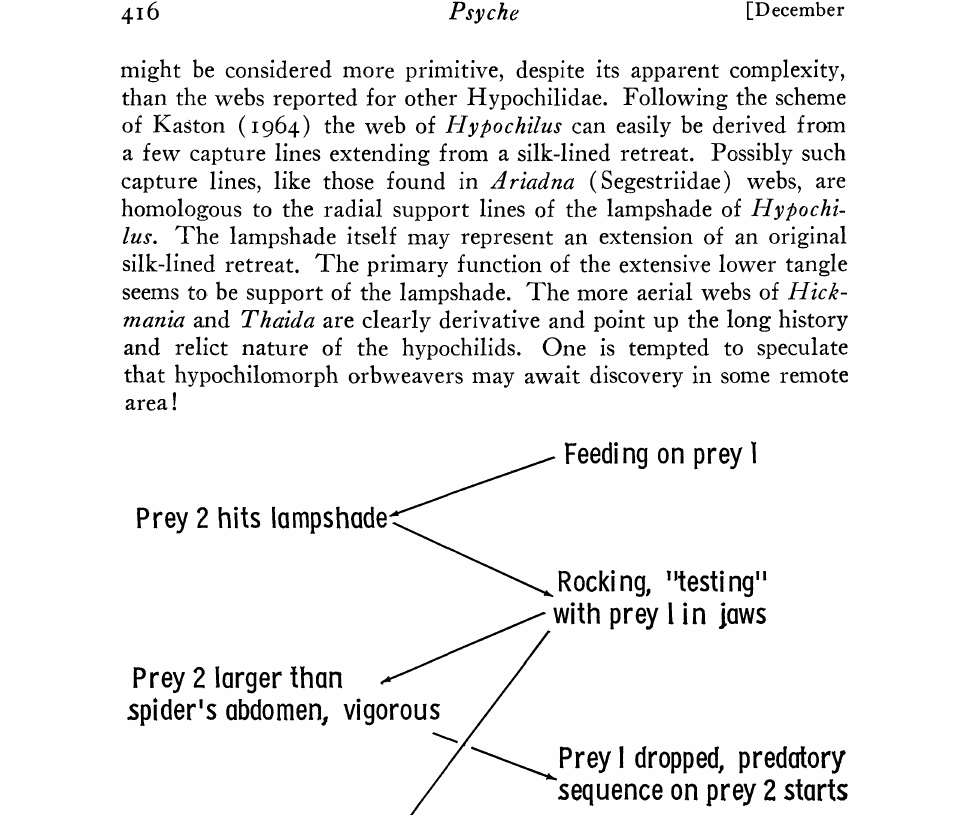
Fig. 10. Response of H. gertschi to a second